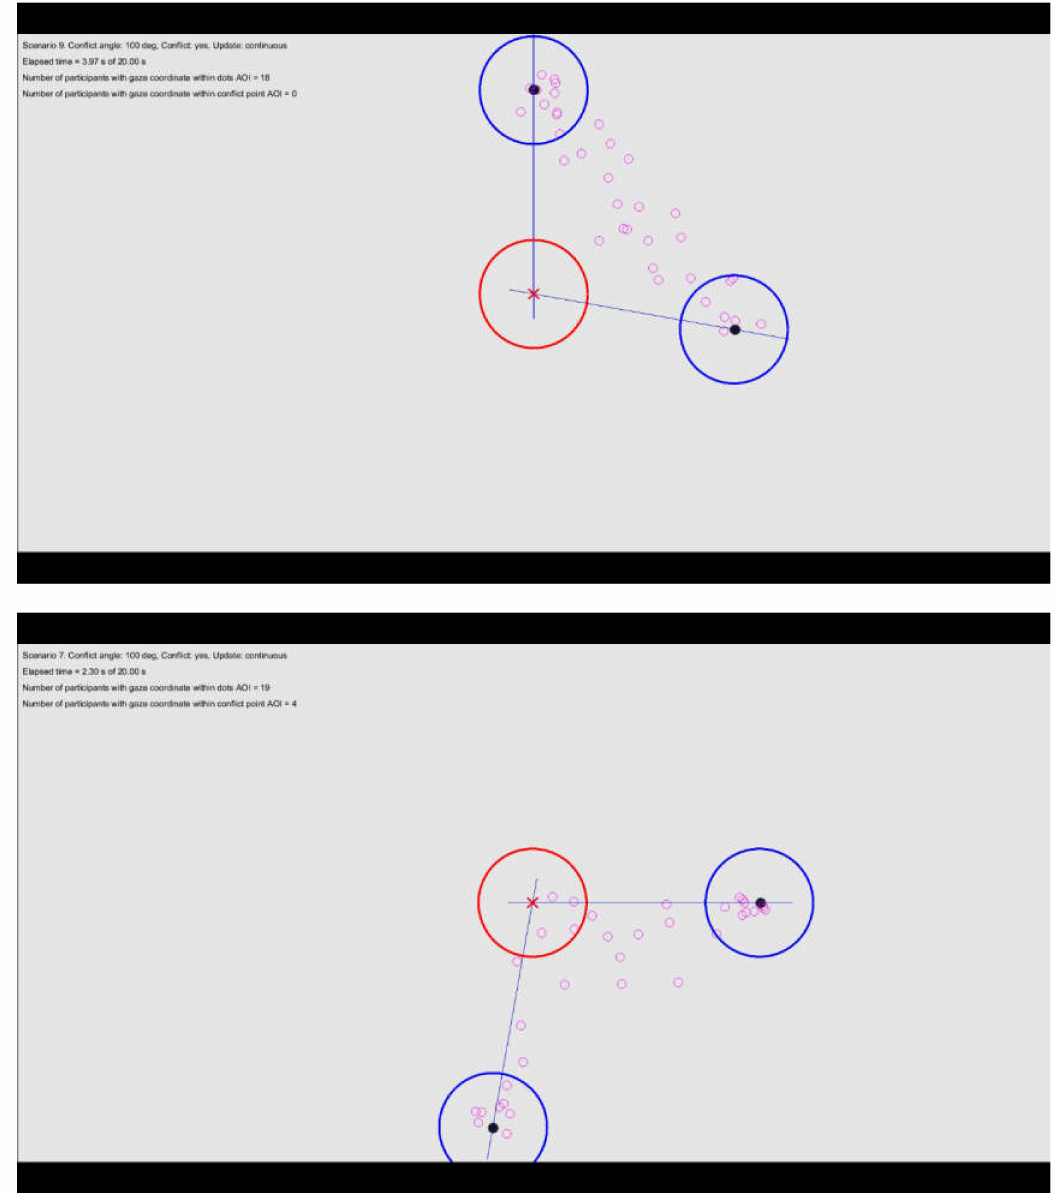
Figure 7. Snapshot from two selected scenarios ( Top : Scenario 9, Bottom : Scenario 7) showing the dots (black circles), the gaze coordinates for the participants ( N = 35), the conflict point (red X), the dots areas of interest (dots AOI, blue circles), and the conflict point area of interest (CP AOI, red circle). In the videos shown to the participants, only the two dots were